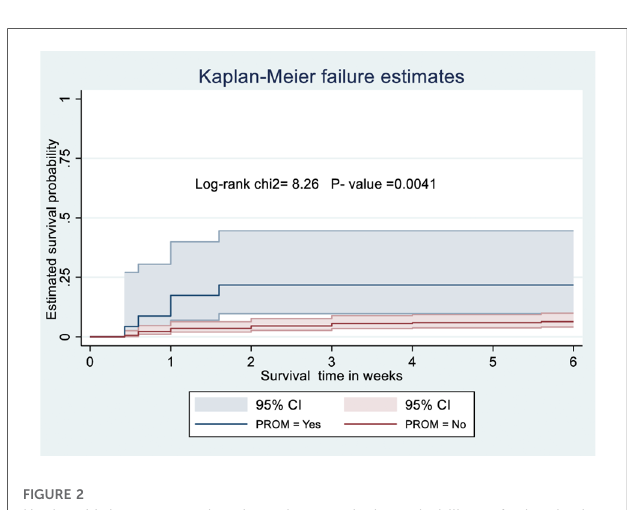
FIGURE 2 Kaplan-Meier curve showing the survival probability of developing puerperal sepsis among postnatal women based on PROM.